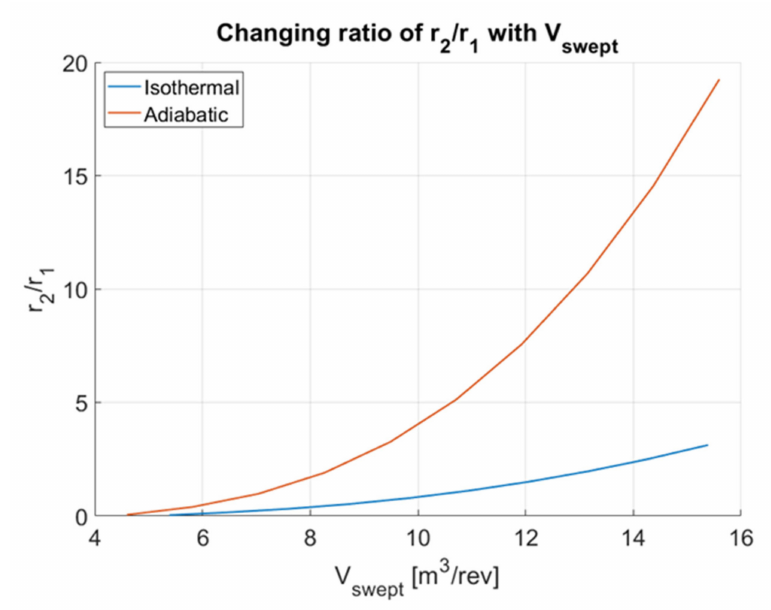
Figure 9. The relationship between the relative power of the main-stage and first-stage compressors and the intake swept volume, in the form of pressure ratio r 2 / r 1 .